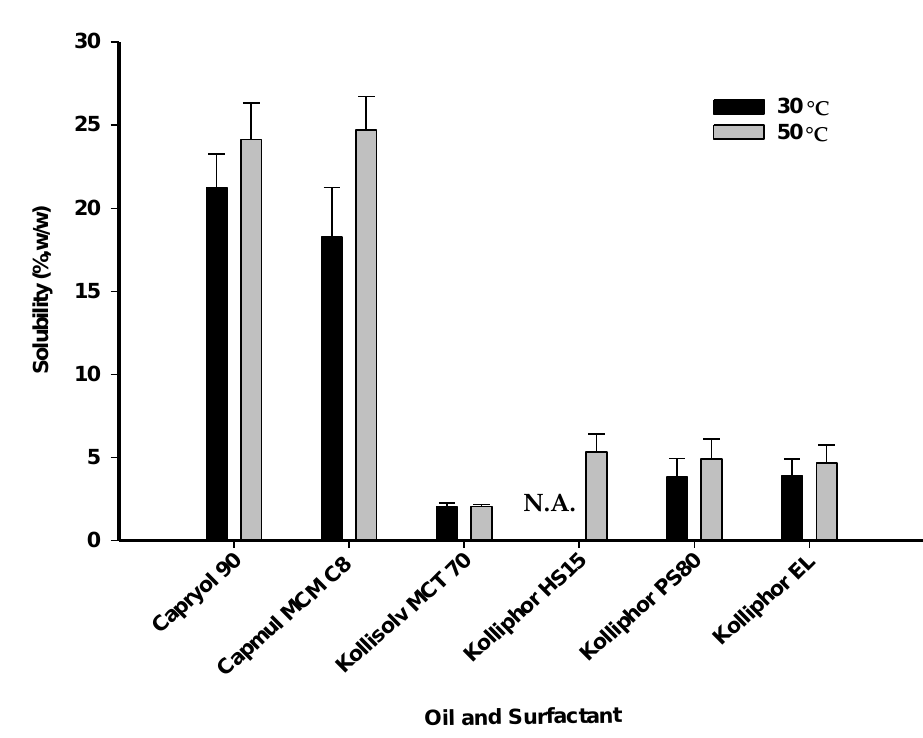
Figure 2. Solubility of PPD in various oils and surfactants. N.A. is not applicable to a temperature of 30 ◦ C, as the melting point of Kolliphor HS15 (over 30 ◦ C) was considered. Vehicle dispersion systems without PPD were categorized into three classes (p.s. < 200 nm, 200 nm < p.s. < 300 nm, and 300 nm < p.s.) depending on the mean particle size values (abbreviated as p.s.). This was indicated on the side line displaying the only combination of oil or surfactant using symbols representing particle size classes. The dotted inner line was drawn from the symbol of